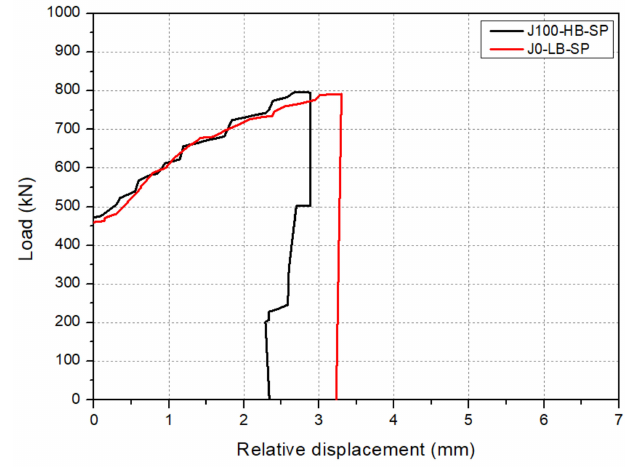
Figure 8. Load–relative displacement curves according to rebar type.